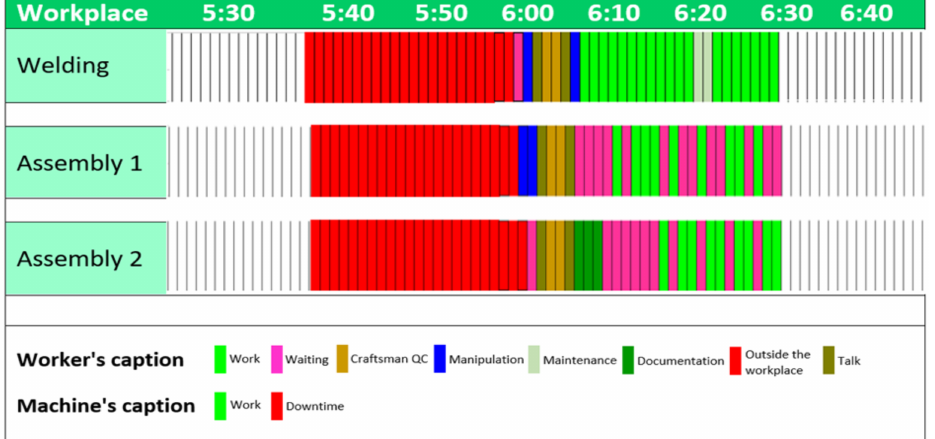
Figure 3. The start of the morning work shift.